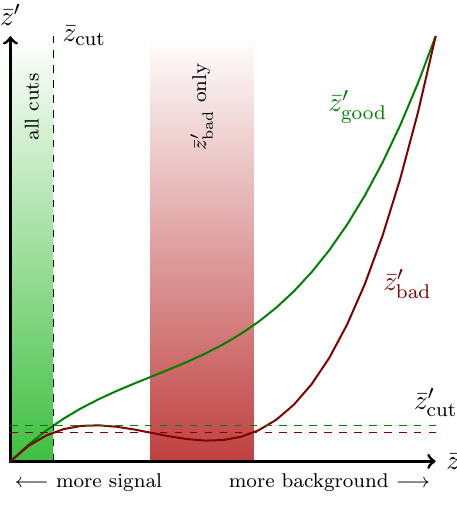
in terms of cuts on an optimal classi(cid:12)er i will always correspond i will i